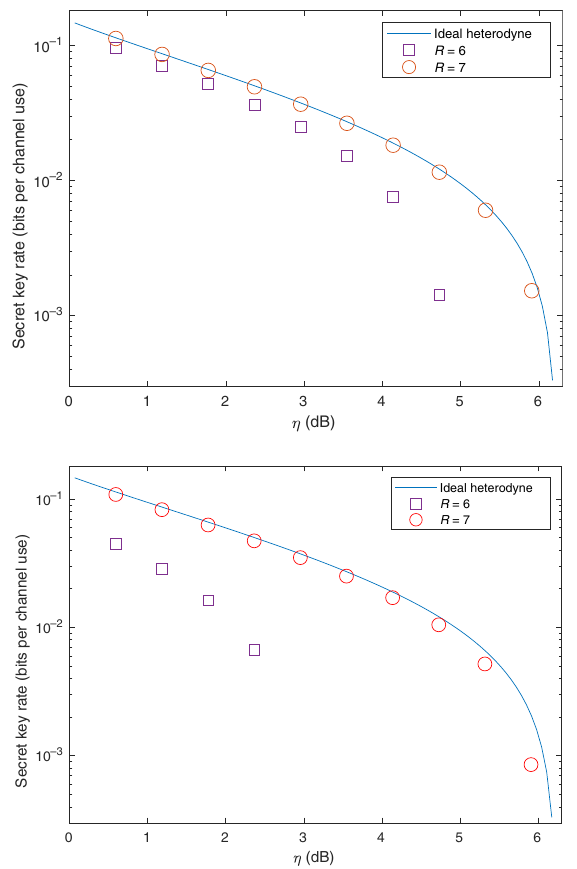
FIG. 1. The asymptotic secret key rates versus the channel loss for QPSK encoding, for collective attacks in the limit of n → ∞ . The channel parameters are | α | = 0.5, u = 0.001, and ξ = 0.97. The solid lines show the theoretical rate expected for ideal heterodyne detection, from Ref. [16]. For nonideal heterodyne, the key rate is computed for d = 16 and R = 6 (squares) and R = 7 (circles). Top: the key rate is obtained by truncating and solving the infinite-dimensional semidefinite programs given in Eqs. (31) and (33). Bottom: the key rate is obtained by solving the finite-dimensional semidefinite programs given in Eqs. (40) and (47).